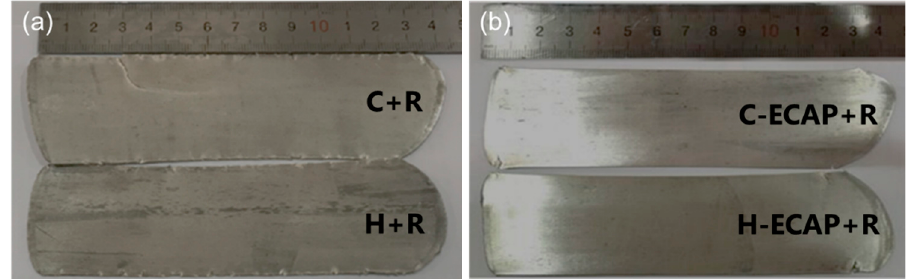
Figure 5. Macroscopic views of ( a ) C + R and H + R rolled alloys; ( b ) C ‐ ECAP + R and H ‐ ECAP + R AZ91 rolled alloys.